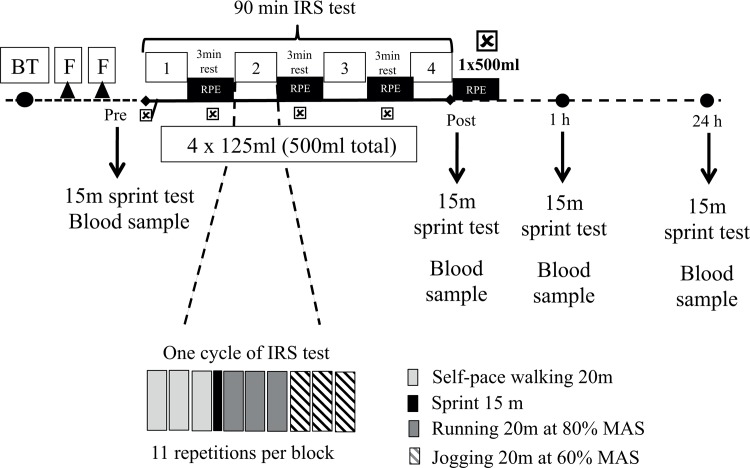
Schematic overview of the study design.BT beep test; F, familiarization Sessions, ☒ MTN, CHO, or PL ingestion; 90 min IRS test: intermittent repeated sprint test involving 4 blocks of 11 cycles of 3 repetitions of 20 m at 60%; one 15m sprint; 3 repetitions of 20 m at 80%, and at 60% maximal aerobic speed; RPE: determination of the rate of perceived exertion value from the 6–20 Borg scale points; 15m: sprint test; Blood: blood extraction from the cubital fossa.